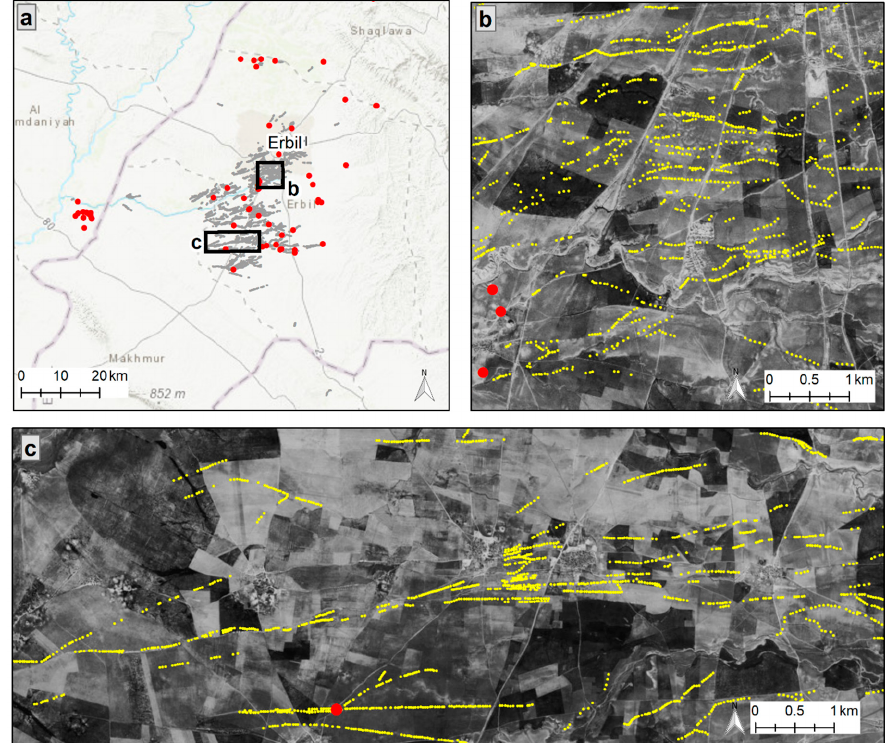
Figure 4. ( a ) Overlay of 51 qanats identified by D. Lightfoot from historic documents and field work (red dots) on approximately 12,000 qanat shafts (gray dots) mapped by EPAS at shaft level using historic CORONA imagery. ( b , c ), enlarged maps for two selected areas illustrate the previous database of qanat (red point) in comparison to the complexity of the qanat landscape captured when shafts are individually identified and mapped (yellow dots). Base Imagery: CORONA frames DS1039-2088DA037 and DS1039-2088DA038, acquired 1968, courtesy of the USGS.